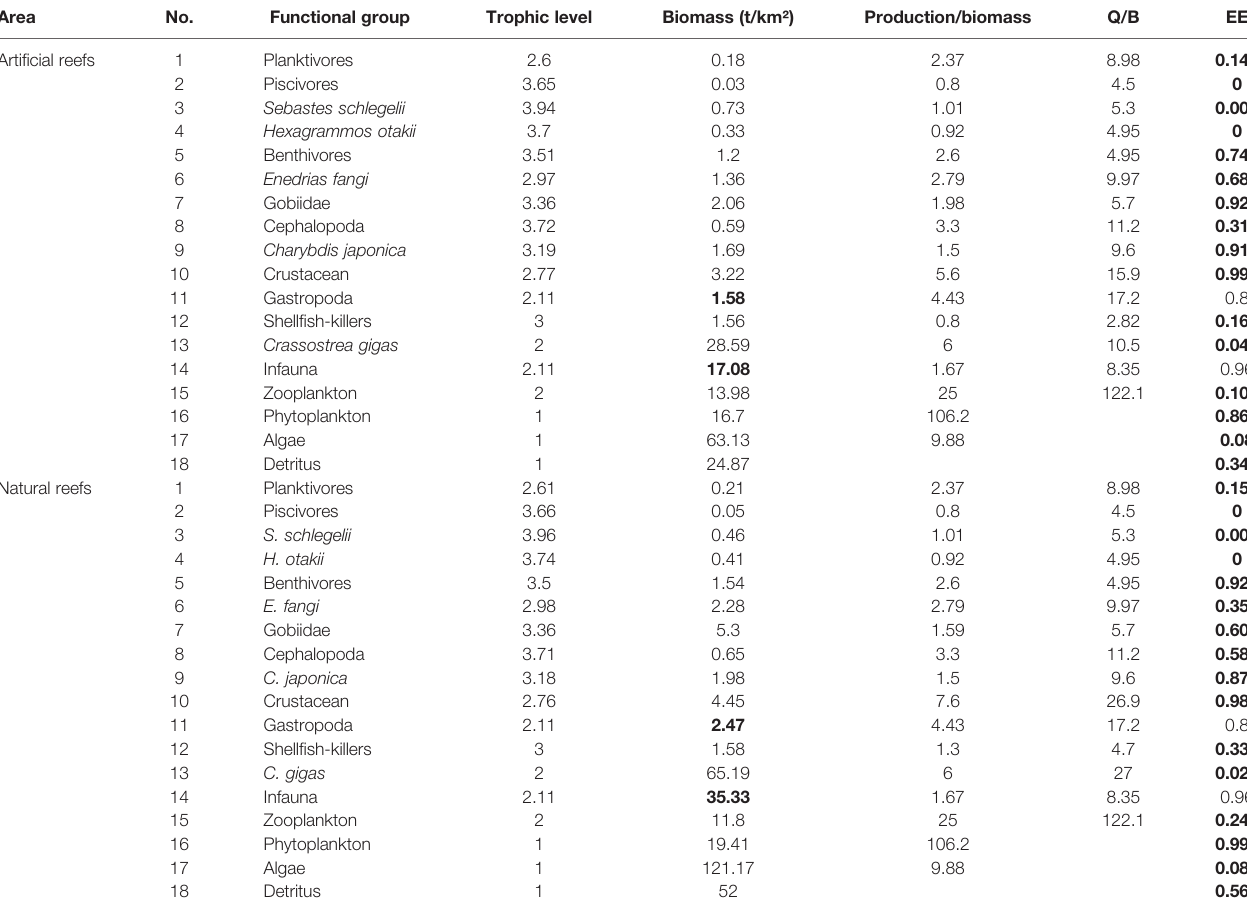
TABLE 2 | Initial input and estimated parameters (in bold) in the Ecopath models of the arti fi cial and natural reefs on the coast of Yellow Sea, China.